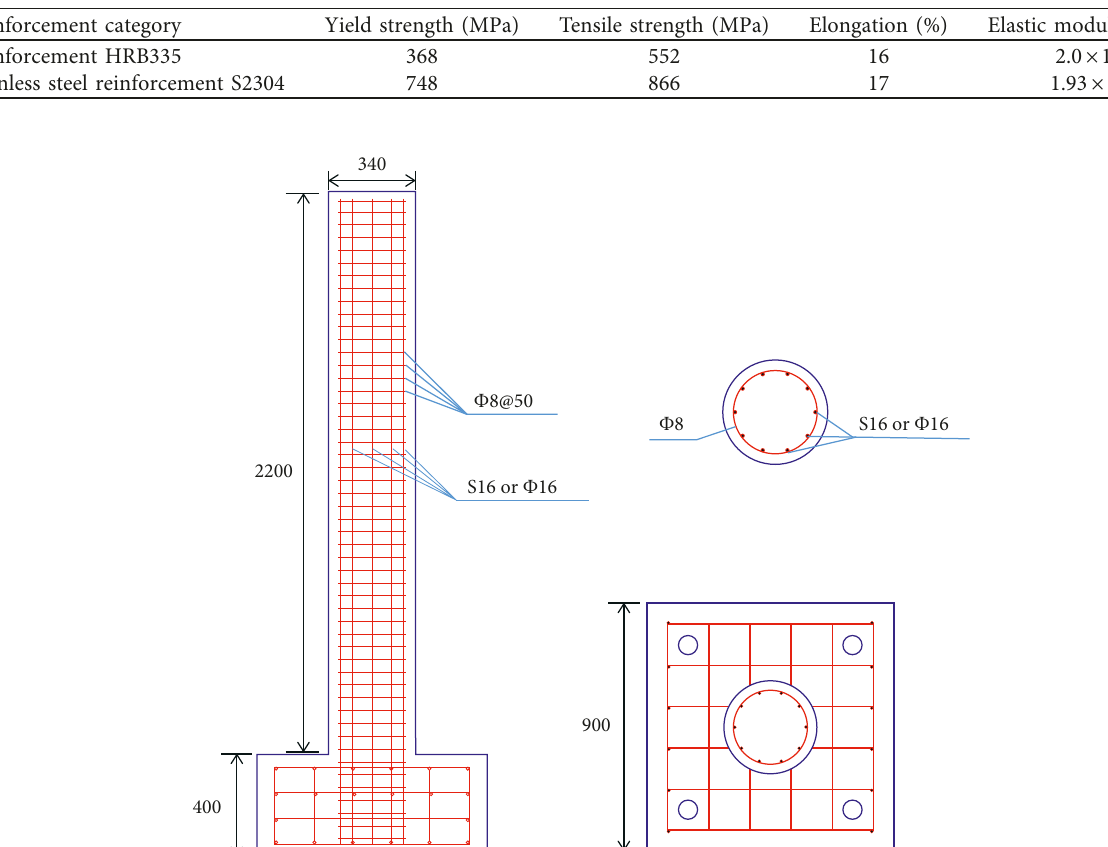
Table 2: Steel reinforcement material performance.